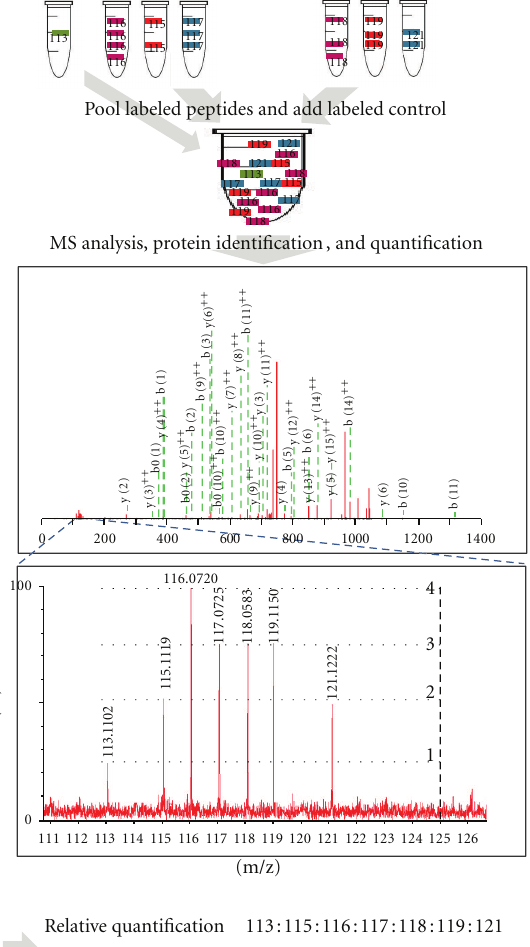
Figure 1: General workflow for patient sampling, iTRAQ labeling, and protein quantification. All patient samples are depleted and trypsin digested separately. Each sample is then labeled with a di ff erent iTRAQ mass tag whereafter the samples are pooled. The pooled samples are fractionated with strong cation exchange and reverse-phase chromatography and analyzed by quadrupole time-of-flight mass spectrometry. The resulting Mascot peptide fragmentation spectra (upper spectra image) provide the peptide sequence and the low mass end (highlighted in lower spectra) shows the iTRAQ reporter ion region used for